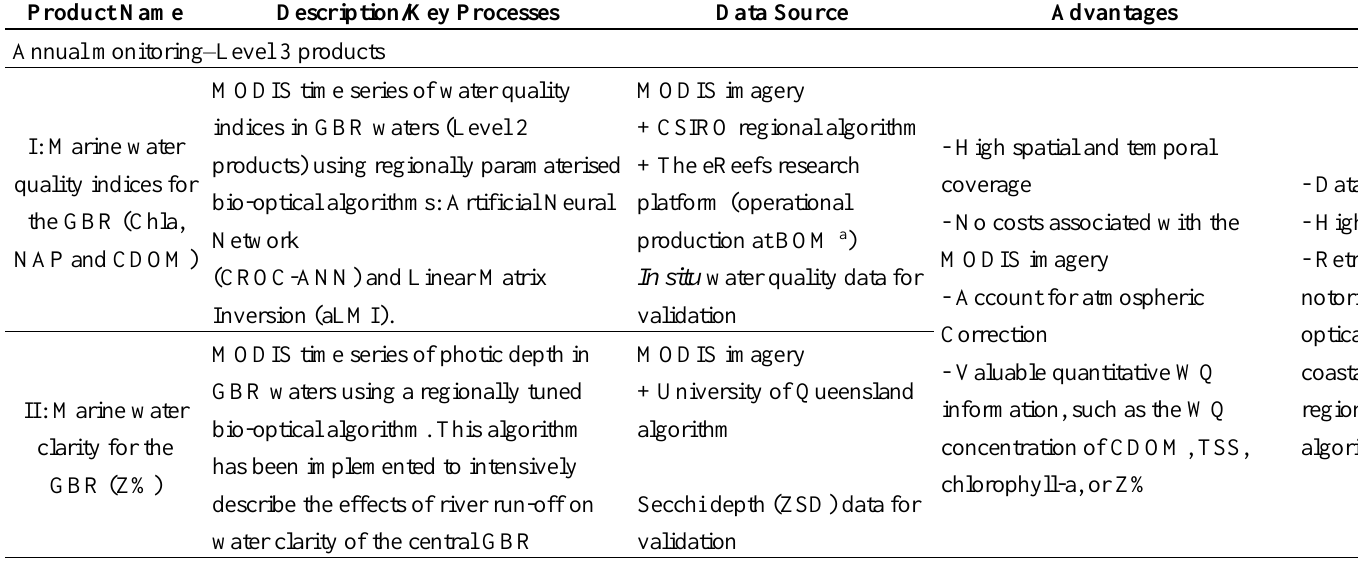
Table 2. Examples of remote sensed products currently applied in water quality monitoring of the Great Barrier Reef. Products in bold relate to analysis of true colour data collected in the wet season only. Based on MODIS data 2002–2014, processed into single-day and multi-day (week, month, season, and annual) composite maps. MODIS products also require continued access to in situ water quality monitoring data for parameterisation and validation. WQ = water